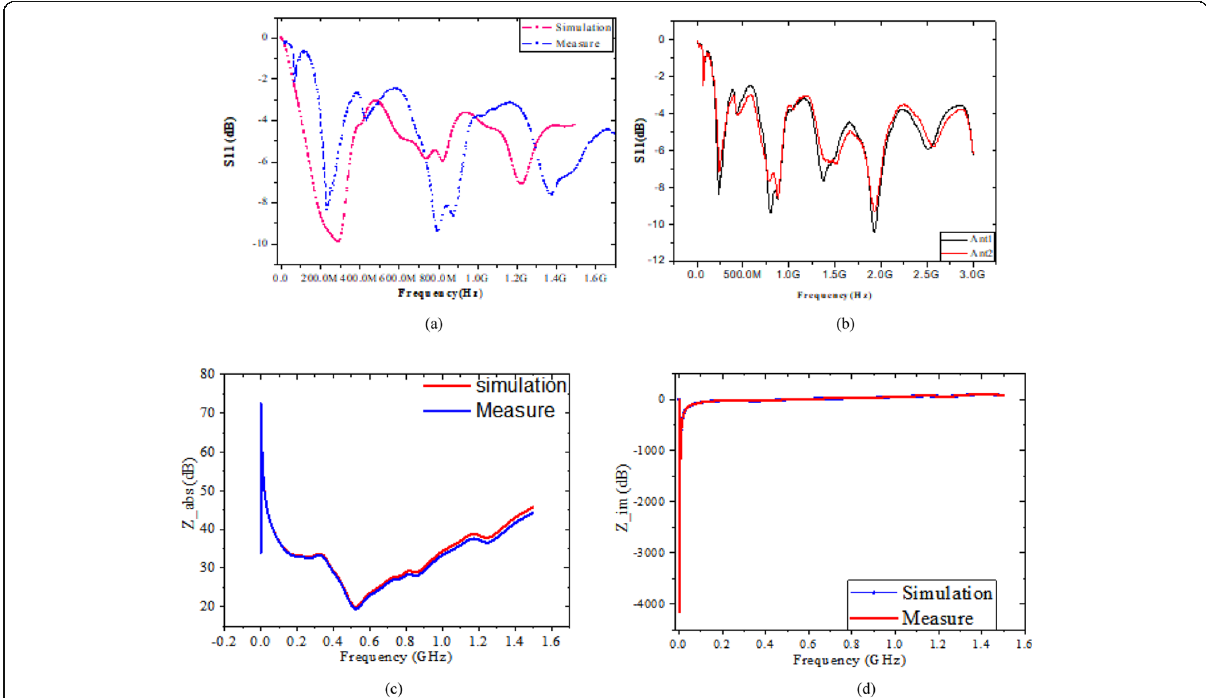
Fig. 7 The antenna S parameters, impedance, and the simulating calculation. a Comparison of antenna S parameter simulation and test results. b Test comparison of S parameter consistency of receiving and transmitting antenna. c Comparison of real-part simulation and test results of antenna impedance. d Comparison of imaginary part simulation and test results of antenna